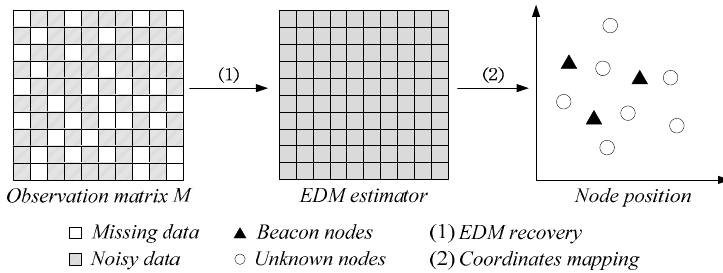
Figure 1. Localization for a wireless sensor network (WSN). The number of nodes is set to 10. In addition, there are three beacon nodes in the WSN.